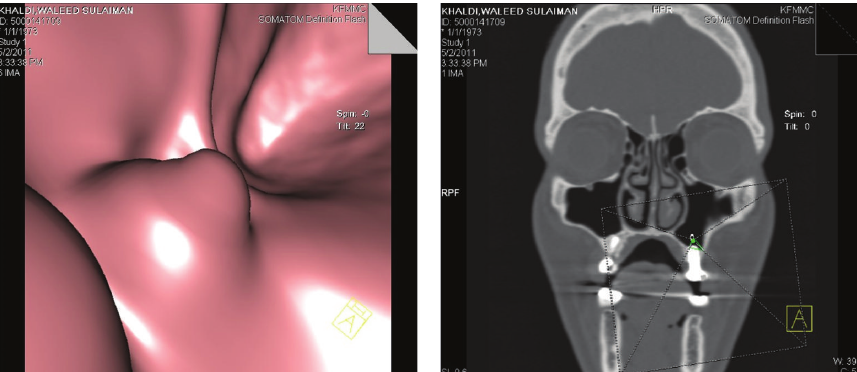
Figure 3: The CT and DentaScan reformatted flythrough image of the staged osteotome sinus floor elevation showing the intact Schneiderian membrane over the projection of the apical border of the first implant.